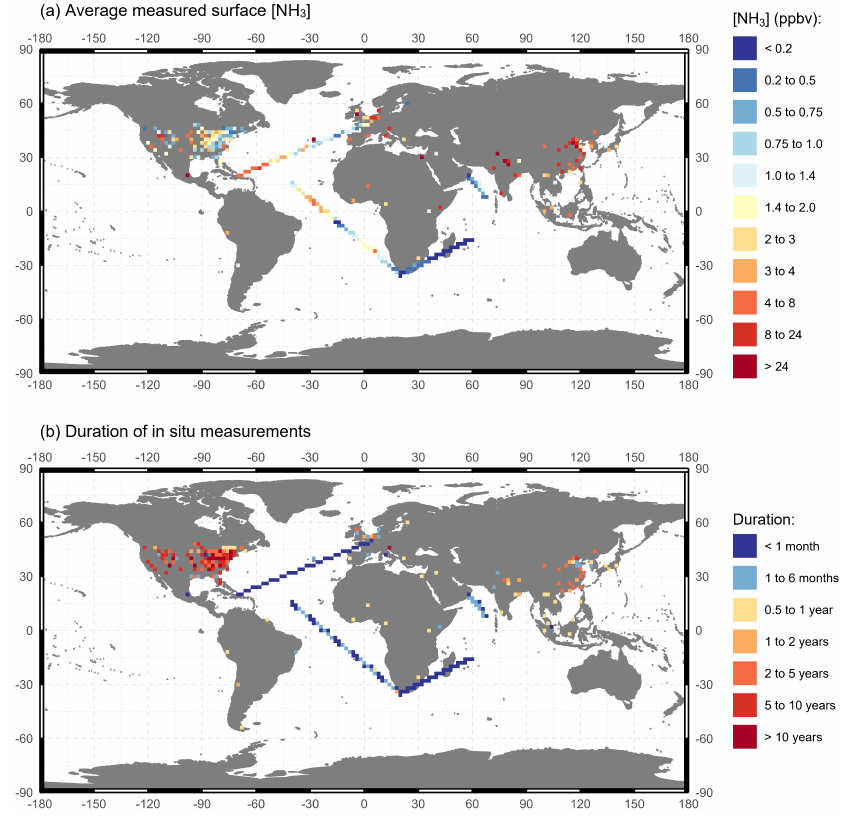
Figure 2. Global in situ measurements reviewed in this paper aggregated to 1° × 1°